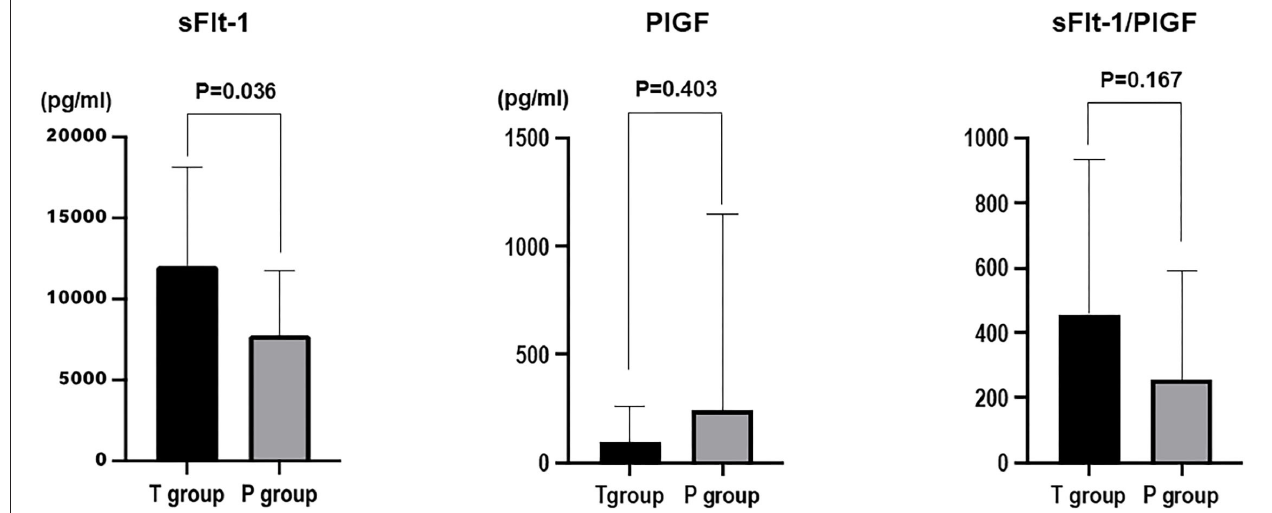
FIGURE 1 | Comparison of sFlt-1, PlGF, and sFlt-1/PlGF ratios between the group that delivered in < 24h (T group) and the group that delivered in more than 24h (P